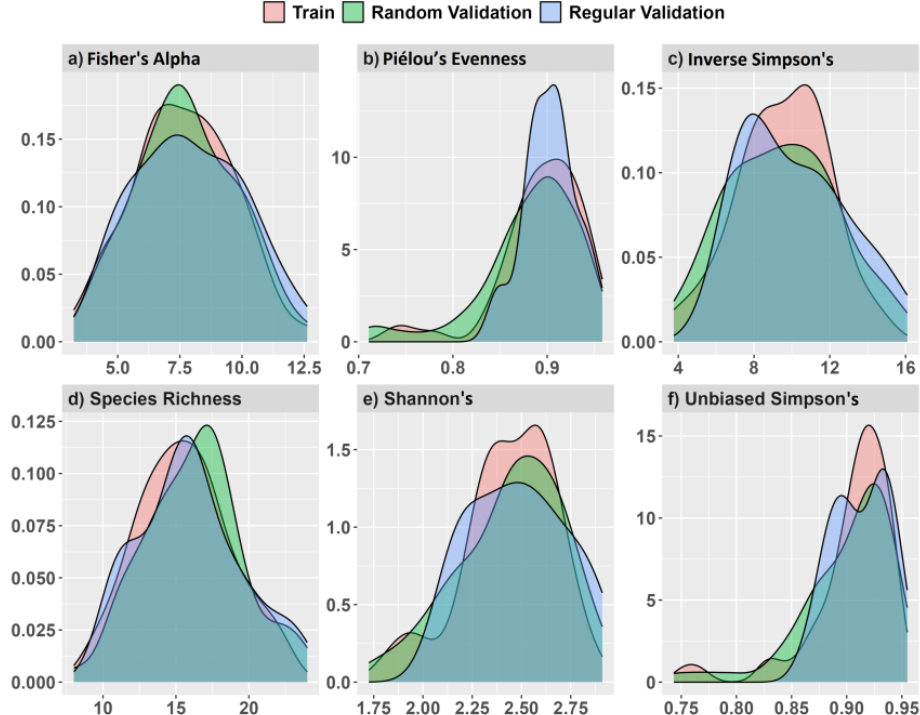
Figure 4. Model training and validation data density distributions from simulated random and regularly spaced 0.10 ha validation plots and values for ( a ) Fisher’s alpha, ( b ) Piélou’s evenness, ( c ) inverse Simpson’s, ( d ) species richness, ( e ) Shannon’s H′, and ( f ) unbiased Simpson’s on the x -axis.